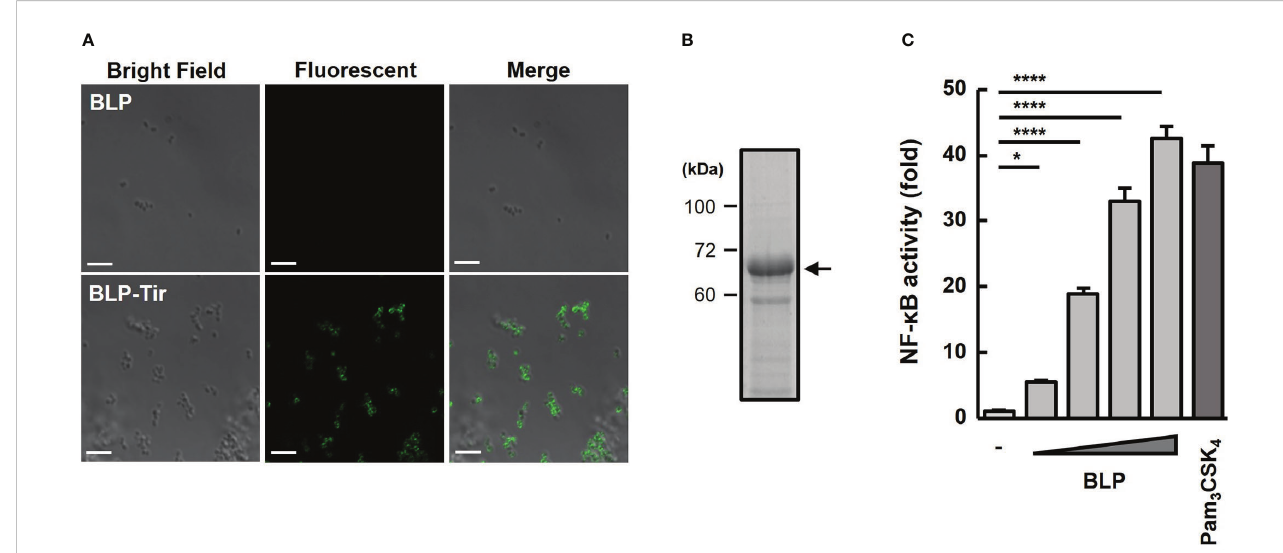
FIGURE 1 Con fi rmation of Tir-LysM binding to BLPs. (A) Immuno fl uorescent microscopic images of BLPs alone (upper) and BLP-Tir (Tir-LysM-bound BLP, bottom) labeled with anti-Tir mouse serum and FITC-conjugated anti-mouse IgG. Bars, 5 m m. (B) BLP-Tir (2 × 10 9 ) was separated by SDS-PAGE, followed by CBB-staining. An arrow indicates 66 kDa BLP-Tir. (C) In vitro assessment of the TLR2 ligand activity of BLPs. Luciferase expression driven by NF- k B activation in HEK293T-TLR2 reporter cells was measured. Cells were stimulated for 24 h with PBS (-, negative control), BLPs (2, 8, 32 and 128 m g/ml), or Pam 3 CSK 4 (100 ng/ml, synthetic TLR2 ligand, positive control). Data were expressed as the means ± SD (n = 3). *, p<0.05 and ****, p<0.0001; one-way ANOVA followed by Dunnett ’ s multiple comparison